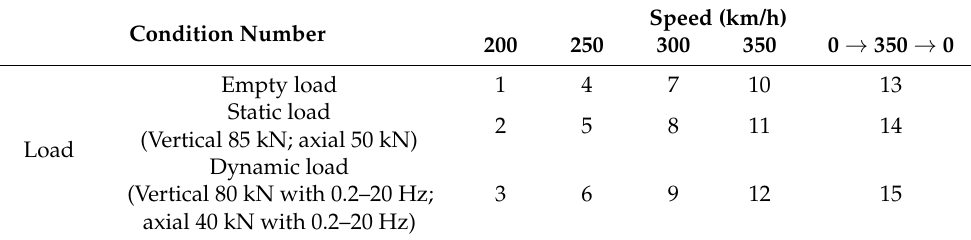
Table 3. Condition number of each running condition.